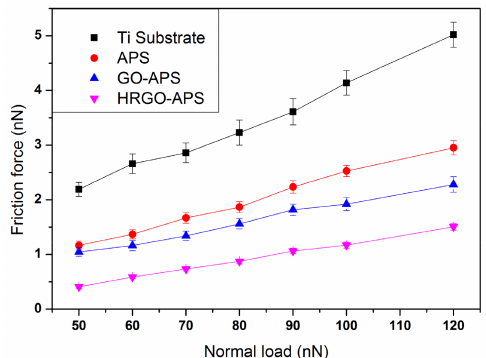
Figure 11. Variation of friction forces of Ti substrate and prepared coatings with the change of applied loads (with scan rate of 2 Hz; scan area: 2 µ m × 2 µ